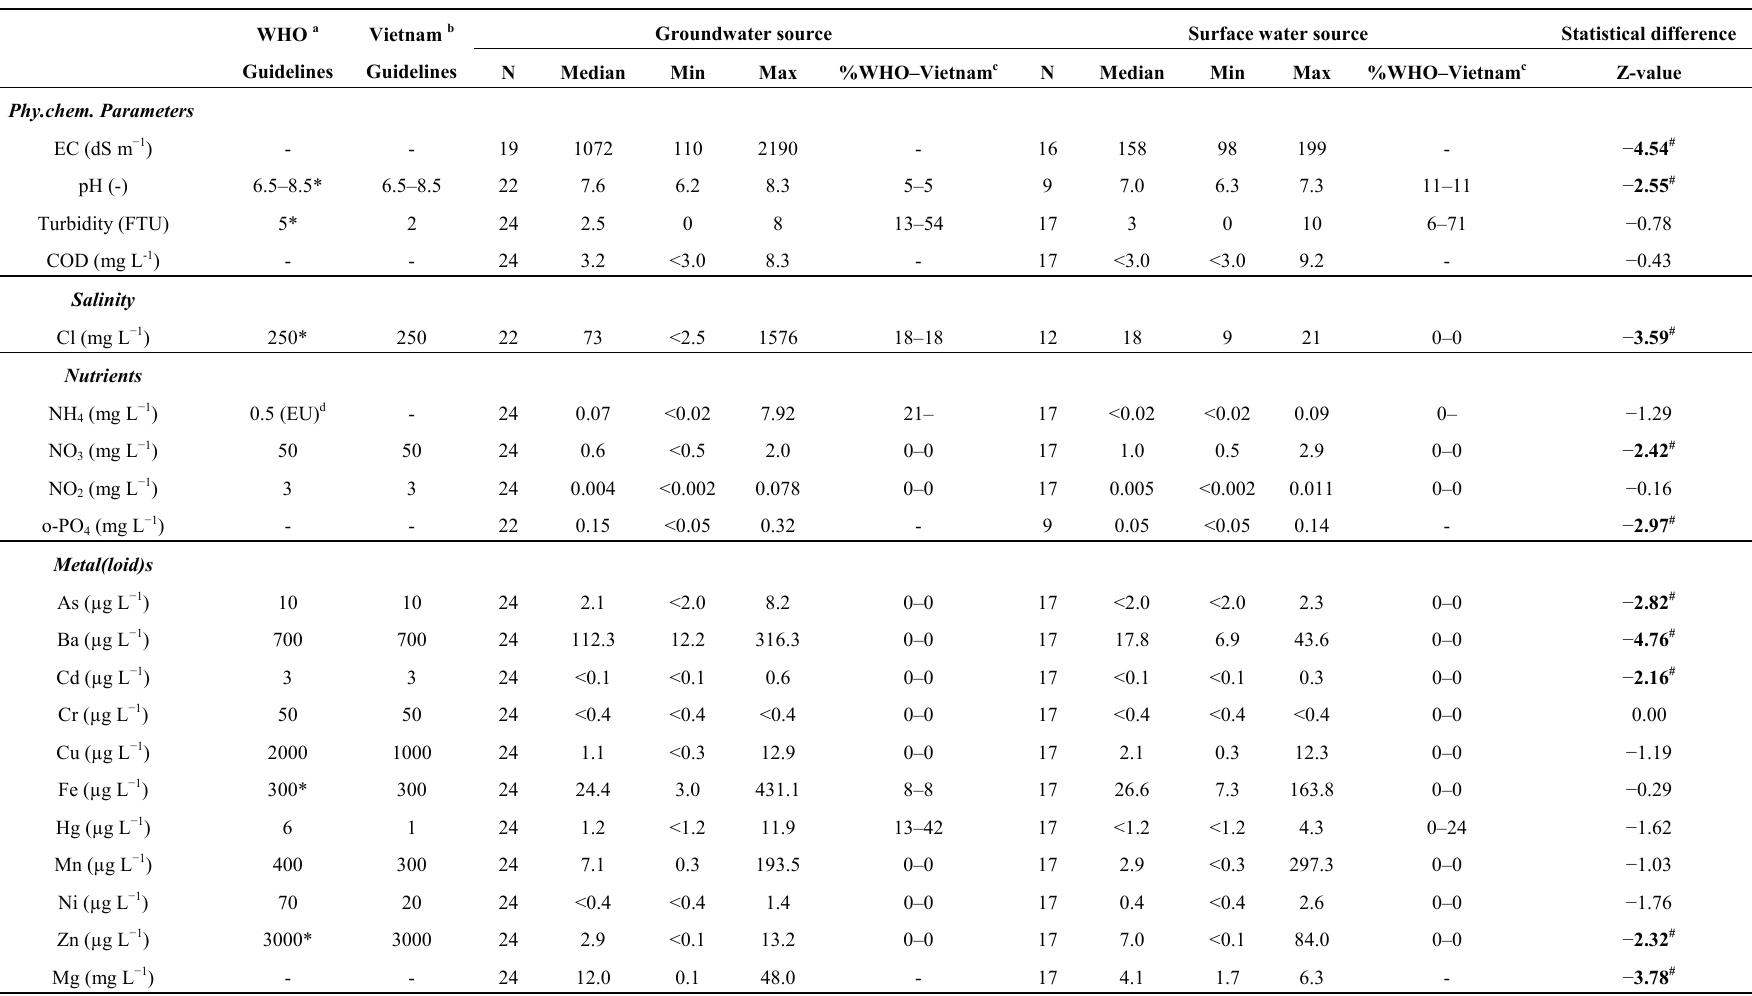
Table 1 . Piped-water quality for 41 water supply stations in three provinces of the Mekong Delta (Can Tho, Hau Giang and Soc Trang). The stations were classified depending on the water source they use for intake. Significant differences in piped-water quality between stations using groundwater and surface water sources are assessed by the Mann-Whitney-U test and visualized by